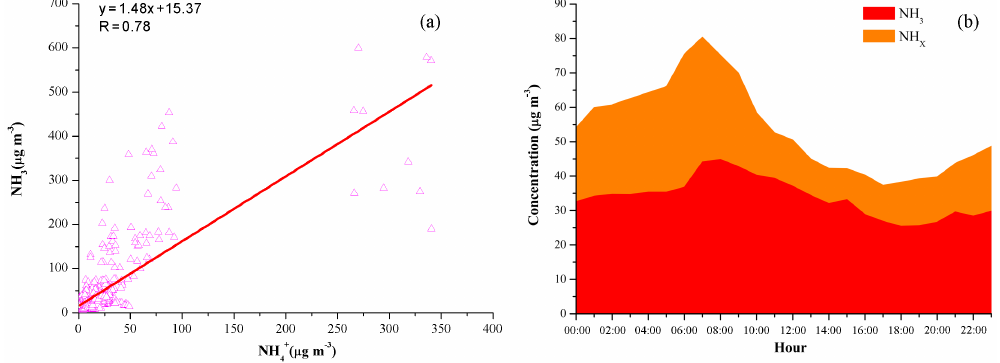
Figure 7. Relationship between NH 3 and NH +